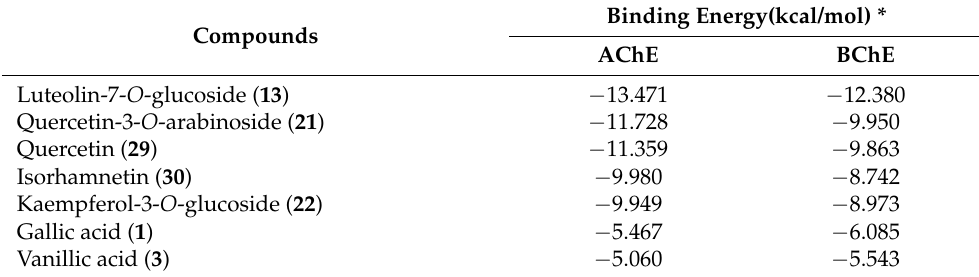
Table 3. Binding energy of enzyme–ligand complexes.